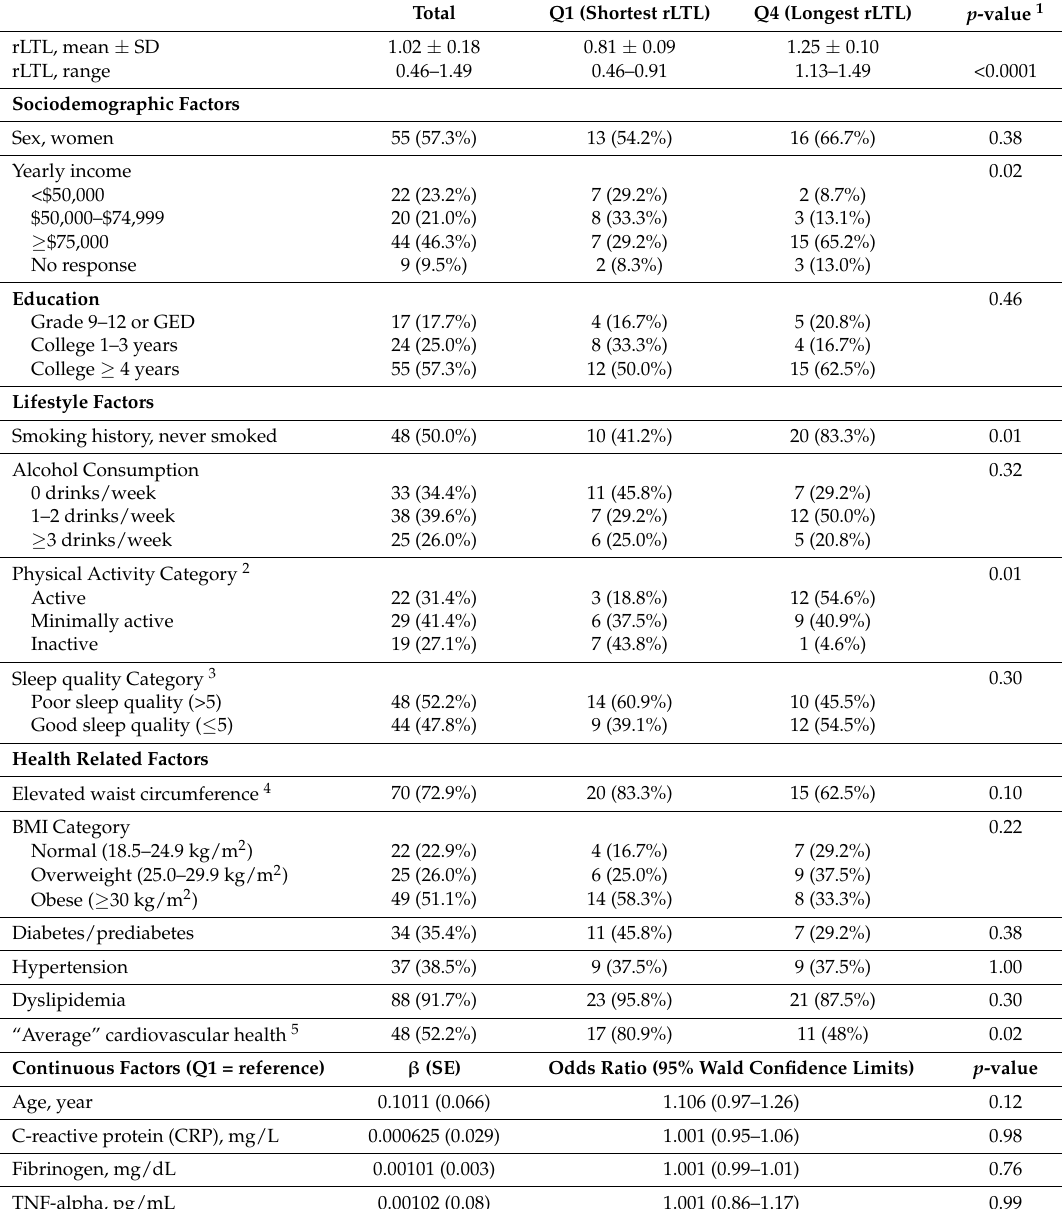
Table 1. The sociodemographic, lifestyle and health-related factors by shortest and longest quartiles of relative leukocyte telomere length